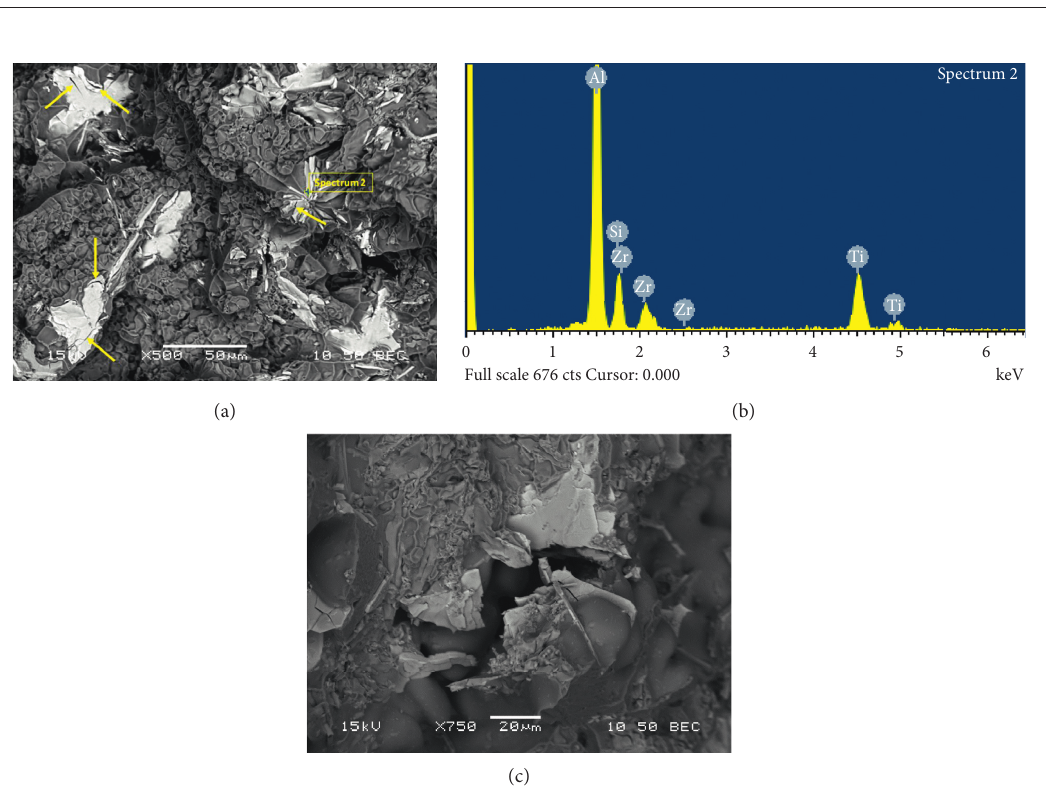
Figure 2: SEM images of T6-treated M1S alloy after stabilization at 250 ° C for 1 hour: (a) BSE image showing a uniform dimple structure and cracked particles (arrowed), (b) EDS spectrum corresponding to the point of interest in (a), and (c) high magnification BSE image showing a cracked Al-Si-Ti-Zr particle.